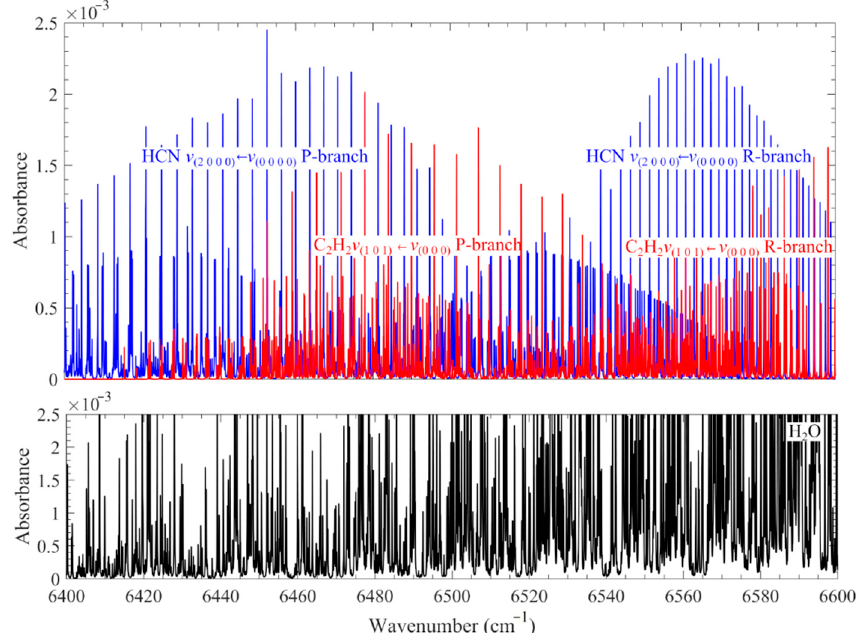
Figure 1. Calculated absorbance of 1000 ppm HCN, 1000 ppm C 2 H 2 , and 10% H 2 O over 6400–6600 cm − 1 at 1200 K and atmospheric pressure with an optical path length of 0.34 m. The spectra data from the HITRAN2016 database were adopted for spectral simulation.